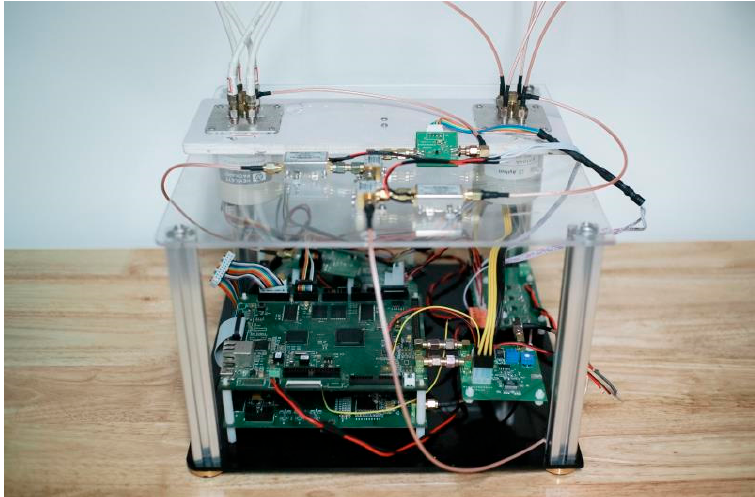
Figure 6. MIMO radar board.